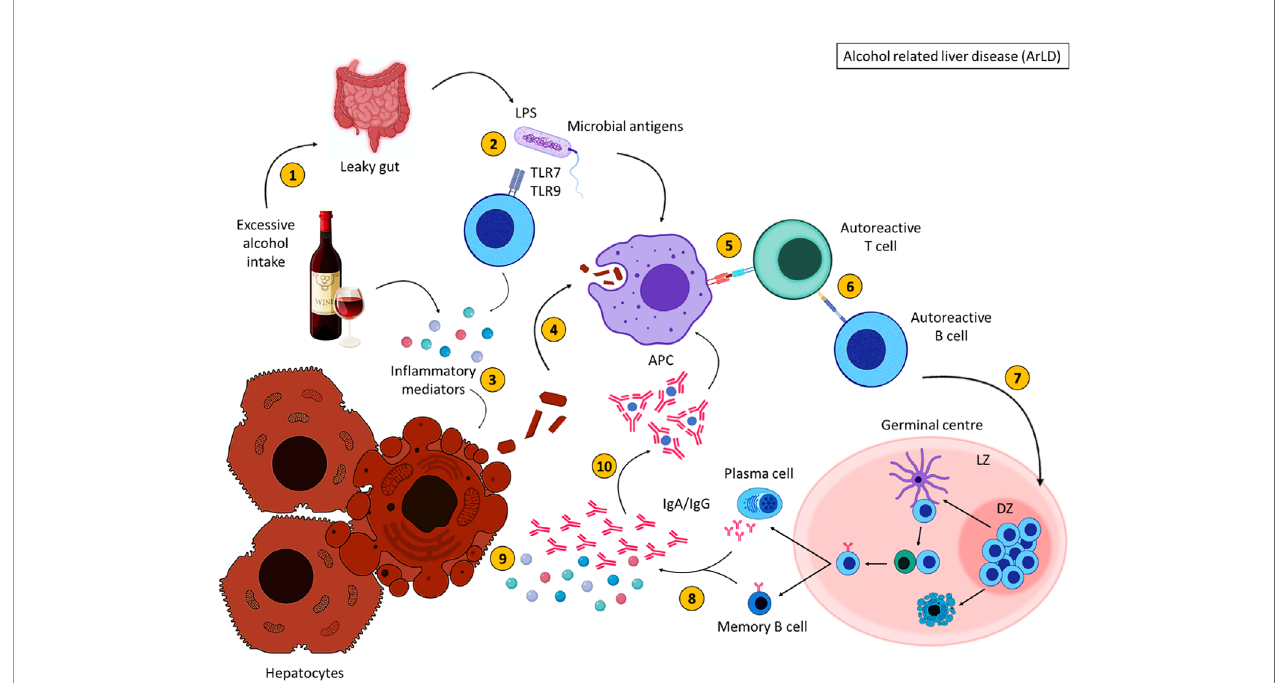
FIGURE 3 | Alcohol related liver disease pathogenesis. Excessive alcohol consumption (1) induces in fl ammation and results in increased gut permeability (2), allowing bacterial translocation of LPS. In fl ammatory mediators damage hepatocytes, resulting in the release of cellular debris (3). Self-antigens are engulfed by antigen presenting cells (4) and presented to autoreactive T cells (5), which stimulate autoreactive B cells (6). Activated B cells then migrate to secondary lymphoid tissues and undergo germinal centre reactions (7) where B cells with increased af fi nity receptors differentiate into memory B cells and PCs (8). The secretion of in fl ammatory mediators and autoantibodies from memory B cells and PCs further damage hepatocytes (9). The formation of immune complexes induces further in fl ammation (10). These immune complexes are engulfed by APCs. Created with